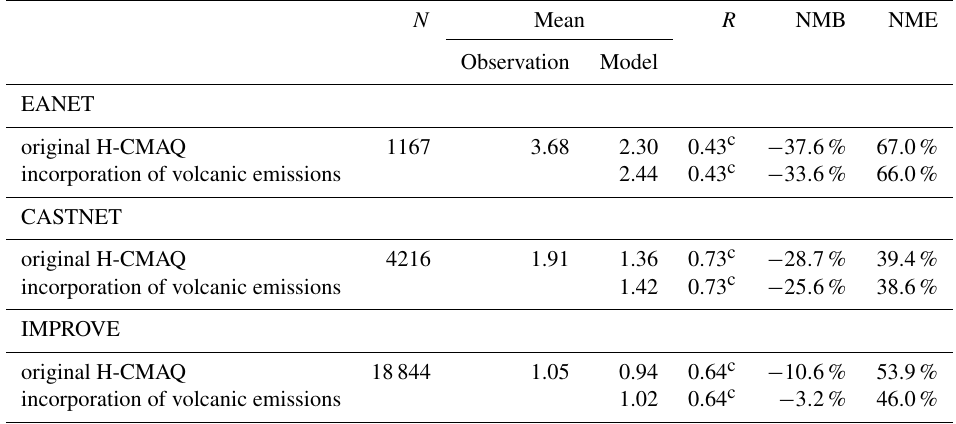
concentration with 4